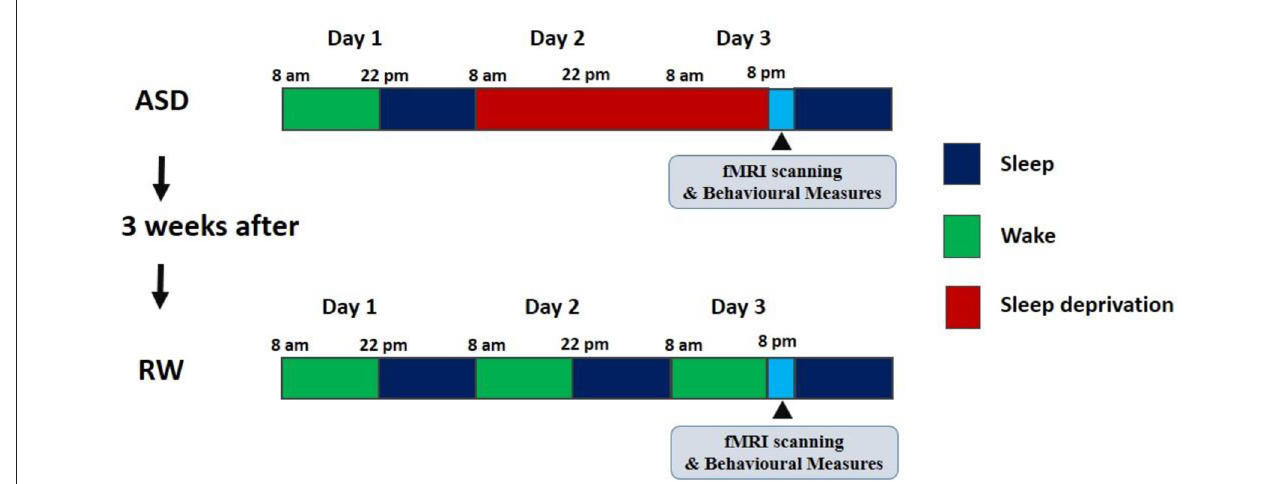
FIGURE 1 | The design of the experiment. ASD, acute sleep deprivation; RW, rested wakefulness.